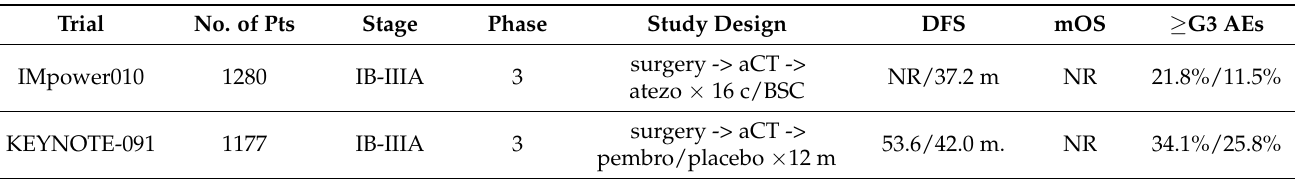
Table 3. Trials of adjuvant immunotherapy in resectable early NSCLC (results available).